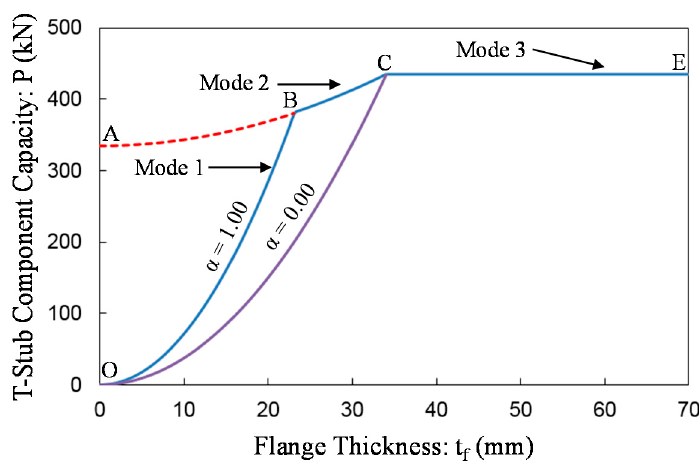
Figure 5. General solution for the failure modes according to increasing flange thickness.